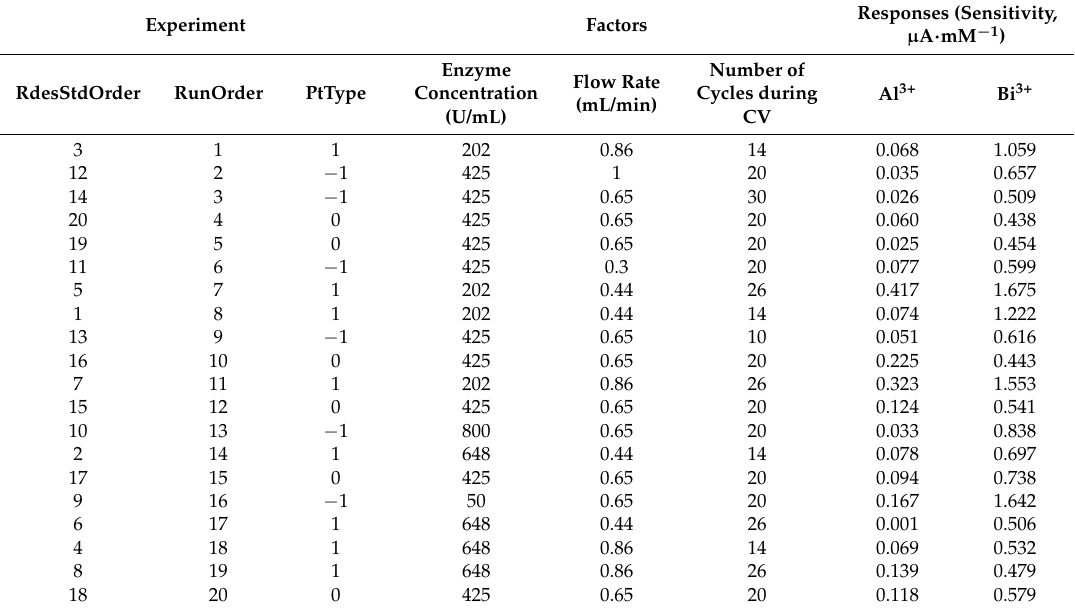
Table 1. Experimental plan and sensitivity in the range of concentration between 15.62 µ M and 31.25 µ M reported for Al 3+ and Bi 3+ .